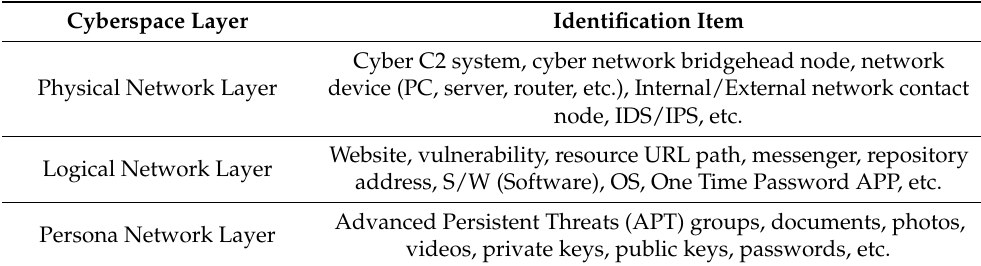
Table 1. Identification Items for each Layer in